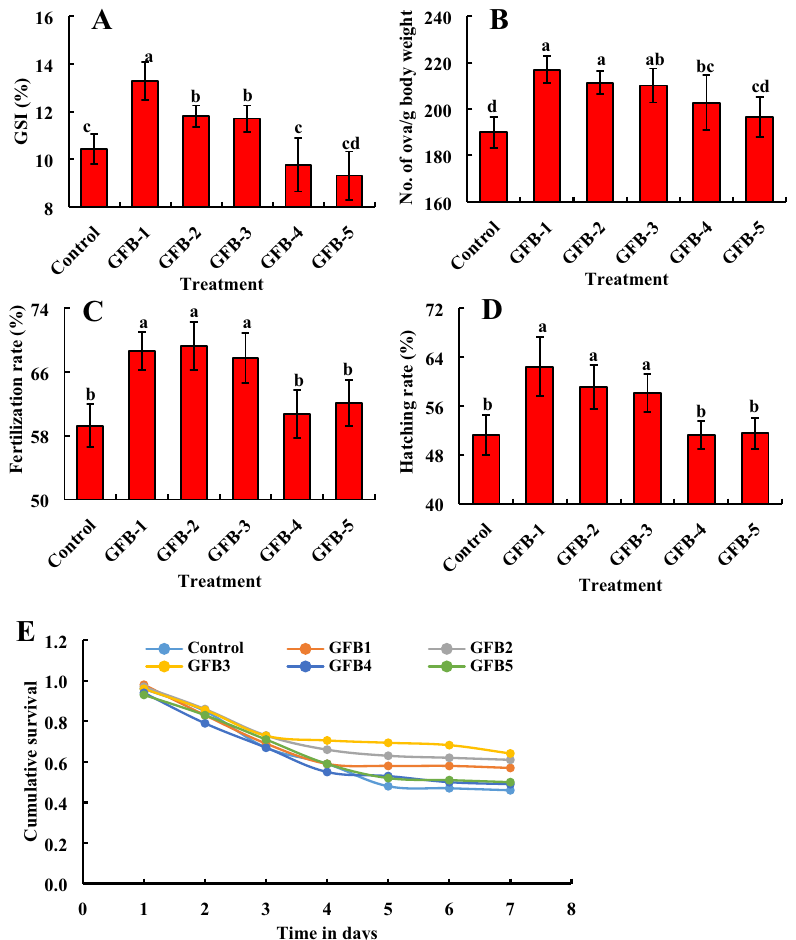
Figure 11. Assessment of individual of probiotic bacterial strains viz . GFB-1, GFB-2, GFB-3, GFB-4 and GFB-5 isolated from the gut of B. gonionotus on reproductive performances (A, B, C, D and E) of the host fish. The fishes were stoked at 16 each replication at ratio of 1:3 of male and female for assessing ( A ) gonadosomatic index (GSI), (B) no. of ova/g body weight, (C) fertilization rate, (D) hatching rate and (E) cumulative survival of larva with a with a 95% CI (n = 100). One way ANOVA was performed for analyzing the data of three replicated experiment and data in column varies significantly in LSD at P < 0.05 (Statistix 10). Different letter bars indicate significant variations in GSI, no. of ova/ g body weight, fertilization rate, hatching rate and survival rate of hatchlings of the host fish in different groups by the isolates at P < 0.05 (Statistix 10). Error bar = ± SD; n =